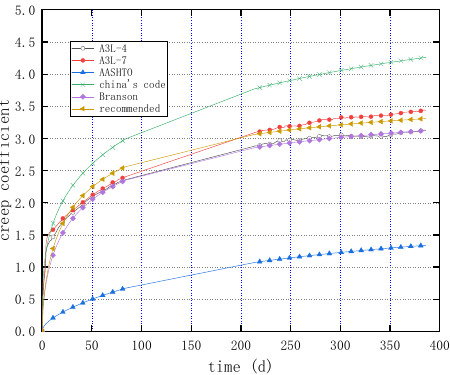
Figure 19. Evolution of creep coefficients of specimens via various approaches (loading age of 3 days).